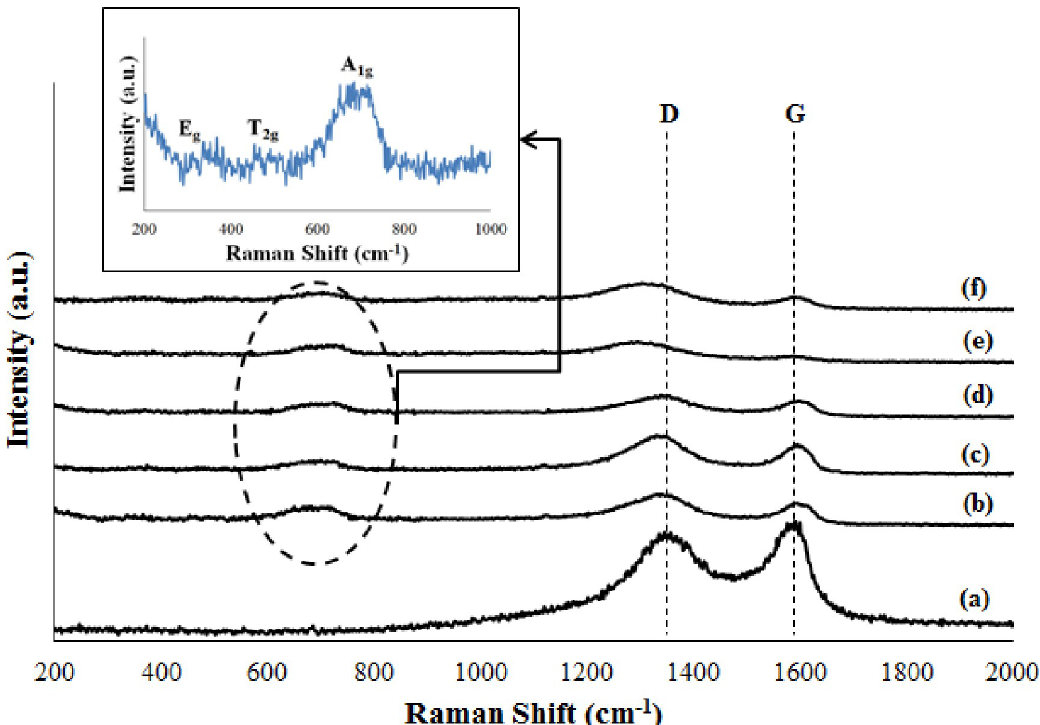
Fig 3. Raman spectra of (a) GO, (b) M-rGO3, (c) M-rGO6, (d) M-rGO12, (e) M-rGO18 and (f) M-rGO24. The inset shows the close view of the representative Raman spectrum (M-rGO3).